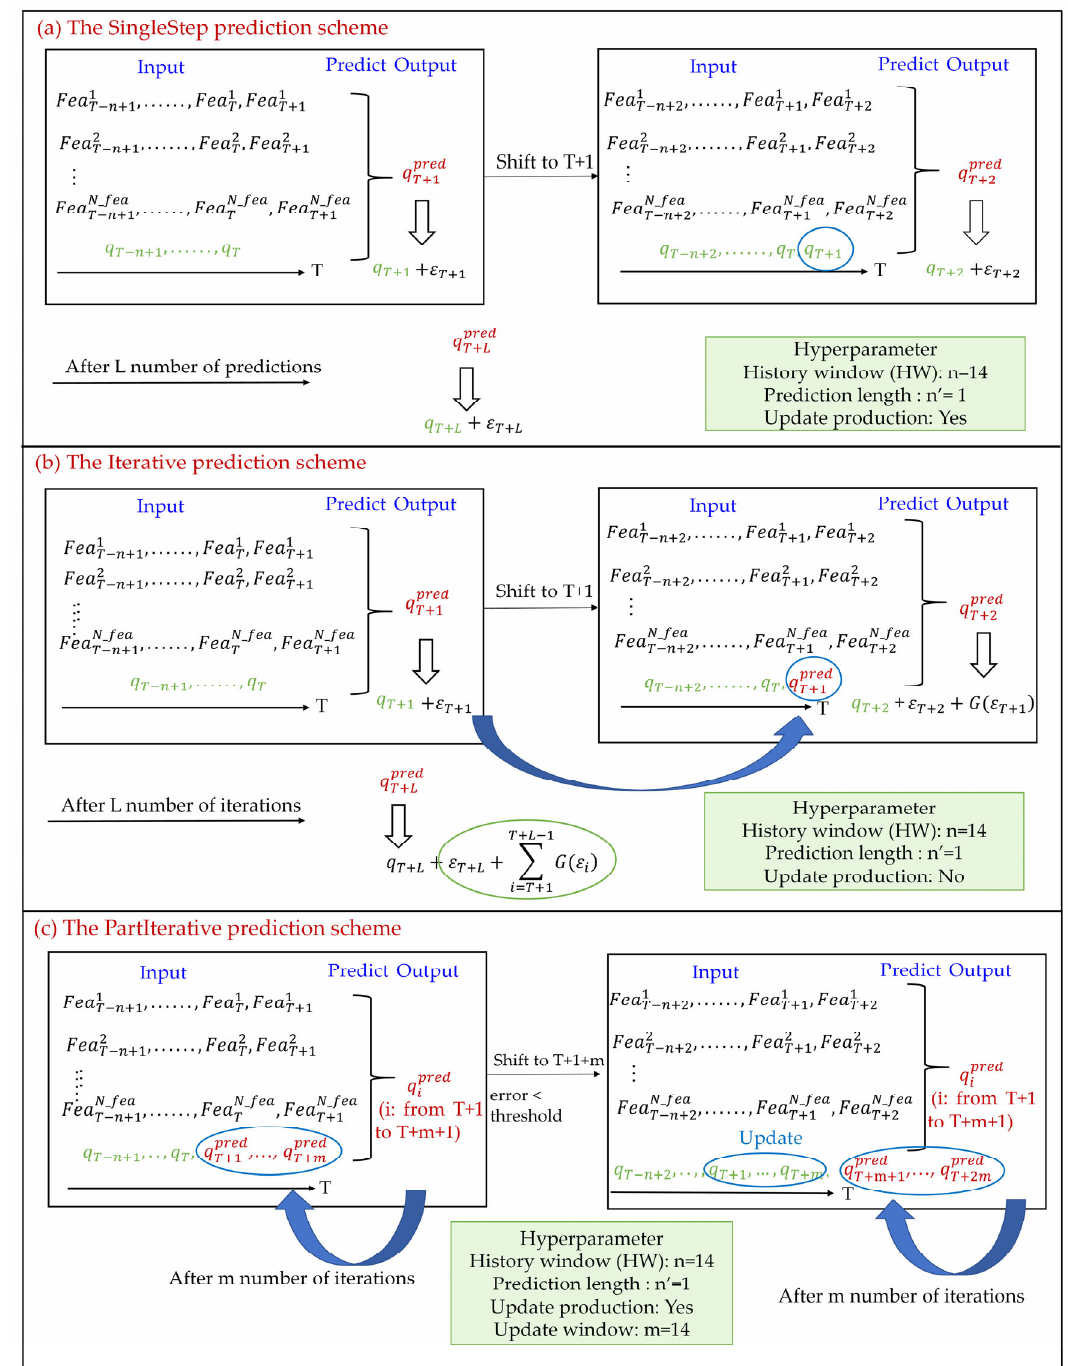
Figure 8. Diagram for the SingleStep, Iterative, and PartIterative prediction schemes: ( a ) the SingleStep approach; ( b ) the Iterative approach; ( c ) the PartIterative approach.